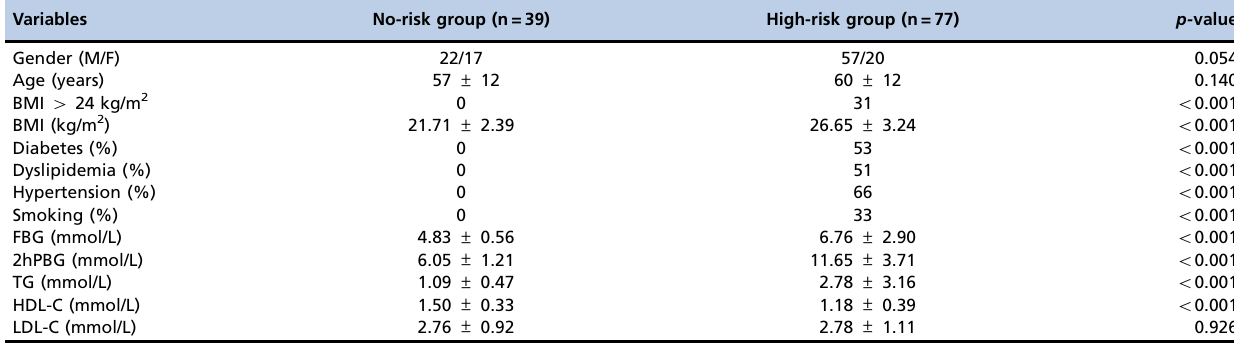
Table 1 - Clinical and biochemical characteristics of the study participants.